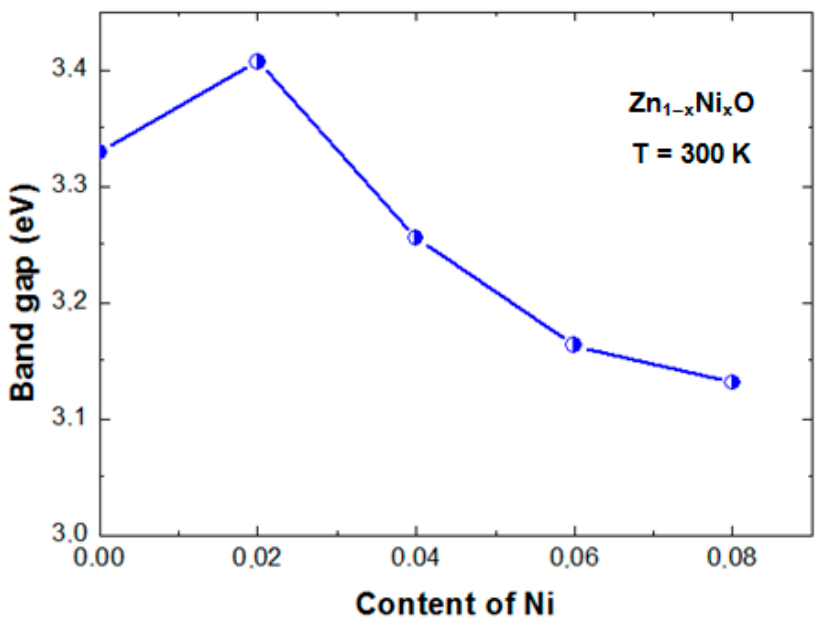
Figure 5. Transmittance spectra of Zn 1 − x Ni x O thin films on different substrates near the absorption edge.